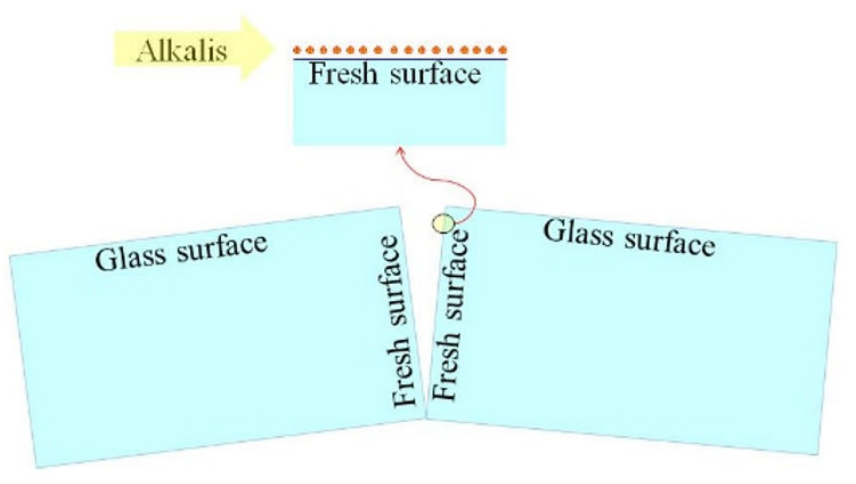
Figure 2. Crushing of complex oxide glass samples creates new surfaces enriched in